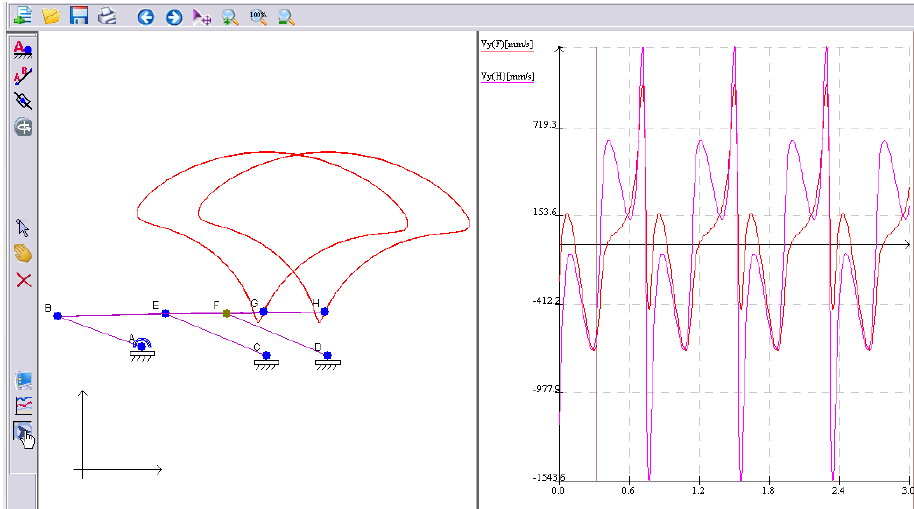
Figure 8. Kinematic diagram and the trajectory of the connecting rod.